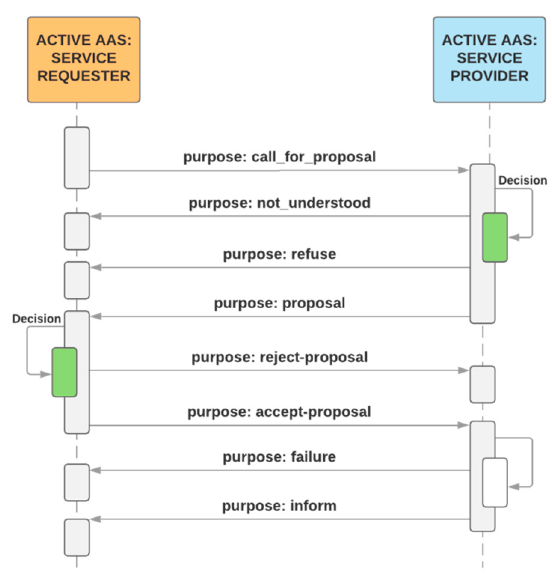
Figure 9. The bidding sequence.